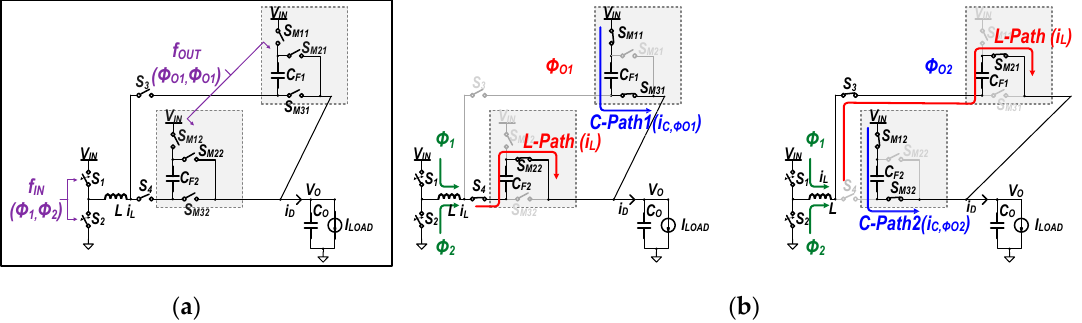
Figure 10. Topology ( a ) and operation ( b ) of a multi-phase buck converter with ETM.